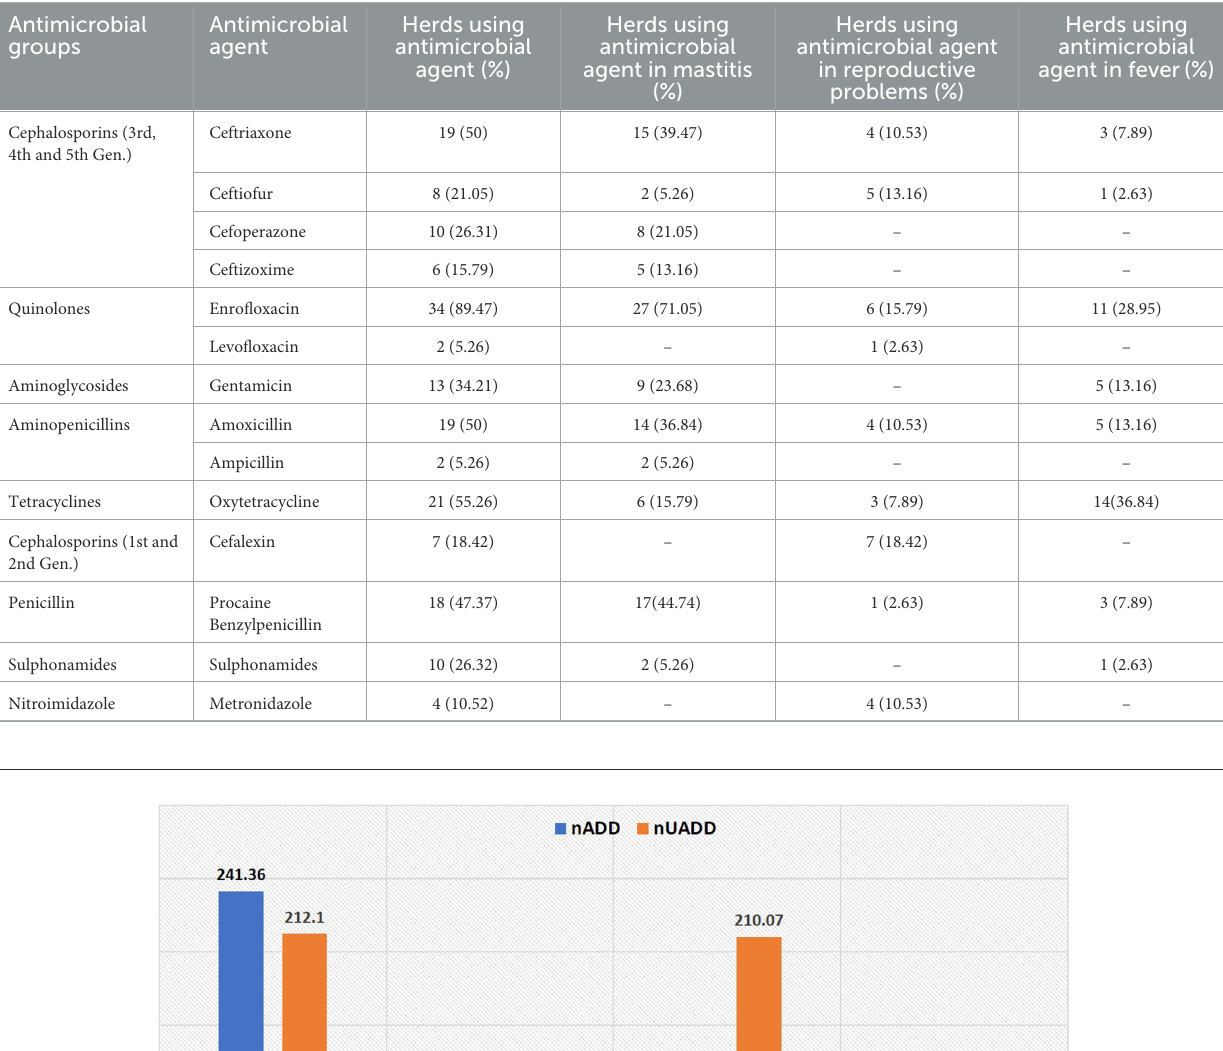
TABLE 2 Frequency of herds using different antimicrobial groups in various conditions. Antimicrobial groups